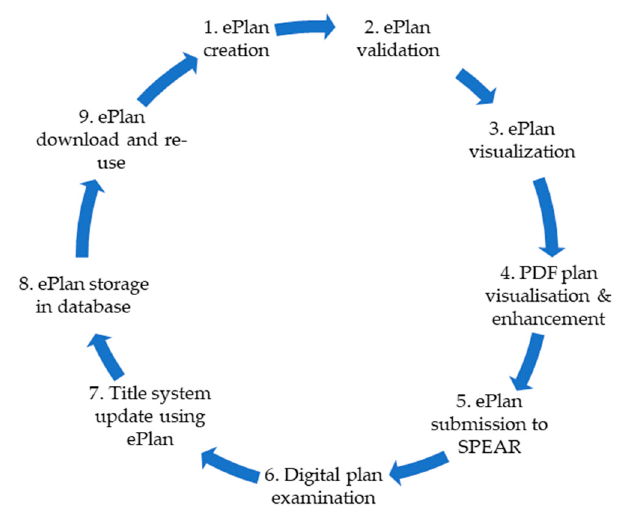
Figure 1. Smart cadastre lifecycle in Victoria.